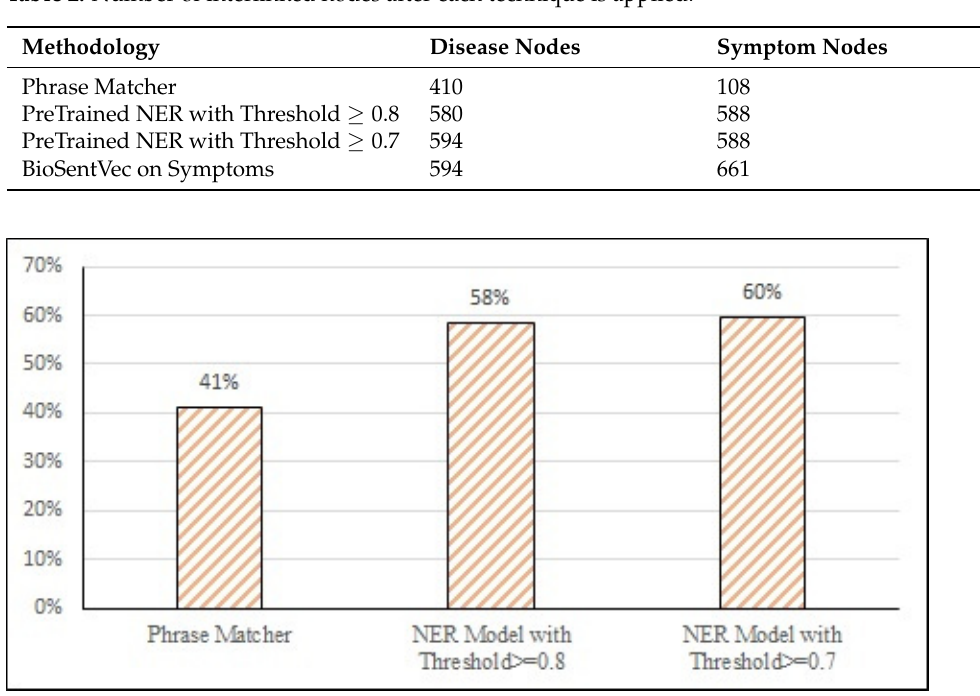
Table 2. Number of interlinked nodes after each technique is applied.